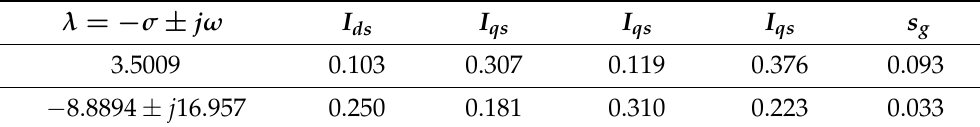
Table 3. Participation factors of leading eigenvalues for s g = 3% at a compensation of